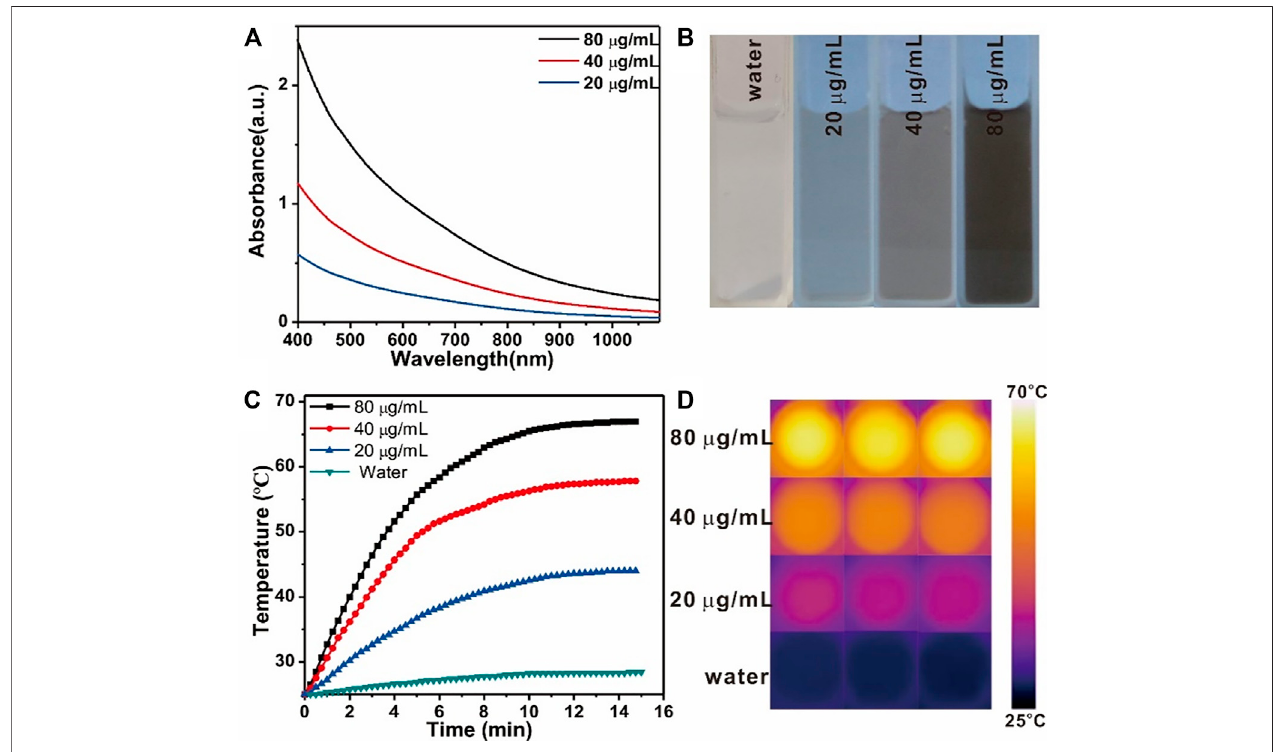
FIGURE 2 | Vis-NIR spectra (A) and the images (B) of Fe 3 O 4 @PDA nanocomposites at a range of concentration levels. Temperature changes (C) and thermal images (D) for Fe 3 O 4 /PDA nanocomposites at a range of concentration levels over the course of NIR laser irradiation (808 nm, 0.8 W/cm 2 , 15